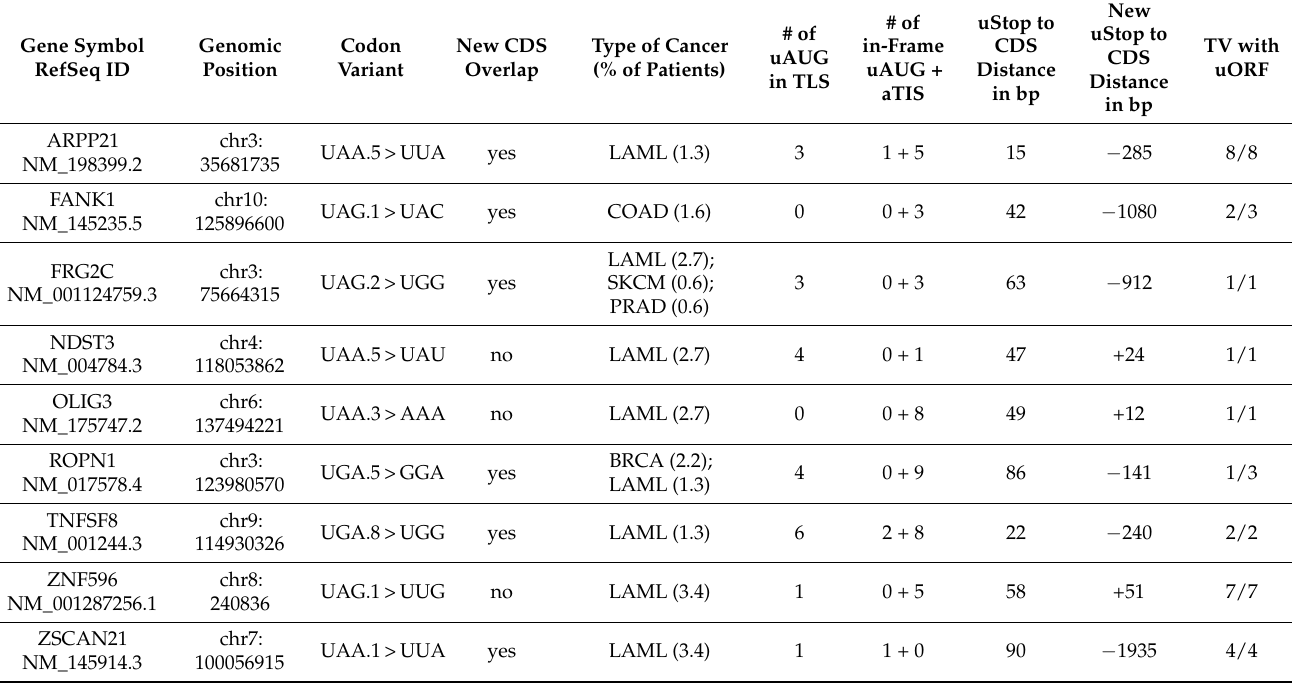
Table 3. List of recurrent somatic SNVs affecting uStop codons selected for experimental analysis.